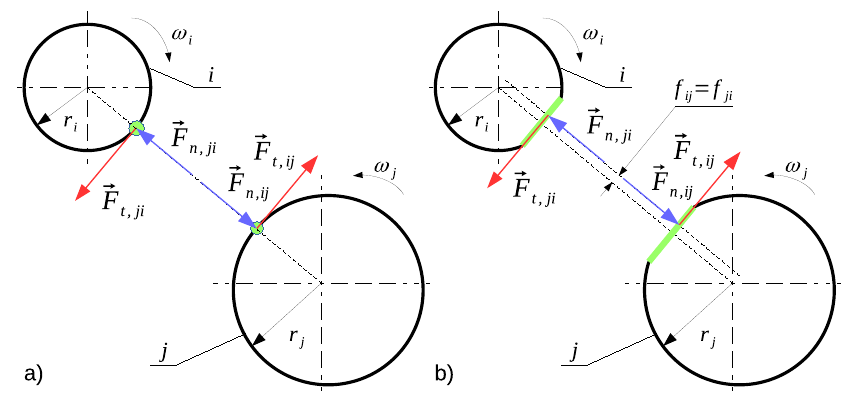
Figure 3. Interaction of two circular or spherical particles: ( a ) hard contact model, ( b ) soft contact